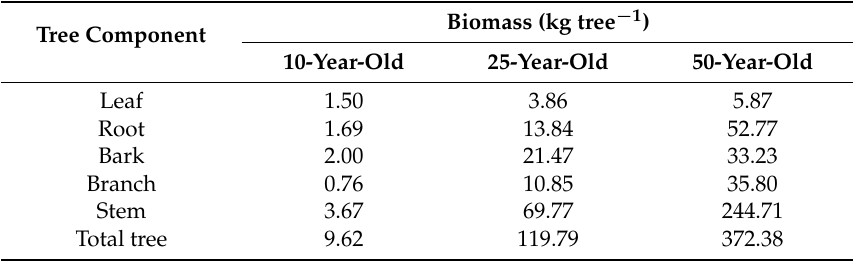
Table 3. Biomass of each tree component for different stand ages in larch plantations. Tree Component